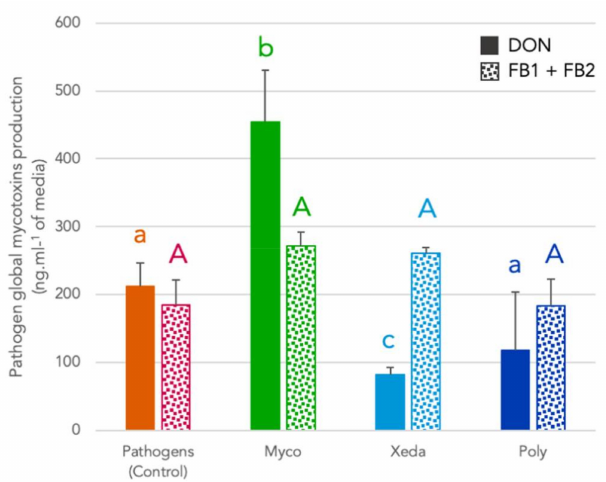
Figure 5. Effect of BCAs mycophagous activity against global production of major mycotoxins of pathogen. Results were obtained after extraction and quantification of mycotoxins in suspension around well, at the end of mycophagy test (after 20 days at 25 ◦ C). Different colors indicate treatment and different patterns indicate mycotoxins type: F. graminearum , DON (full colors) and F. verticillioides , FB 1 + FB 2 (small squares pattern). Myco: Mycostop ® , Xeda: Xedavir ® , Poly: Polyversum ® .